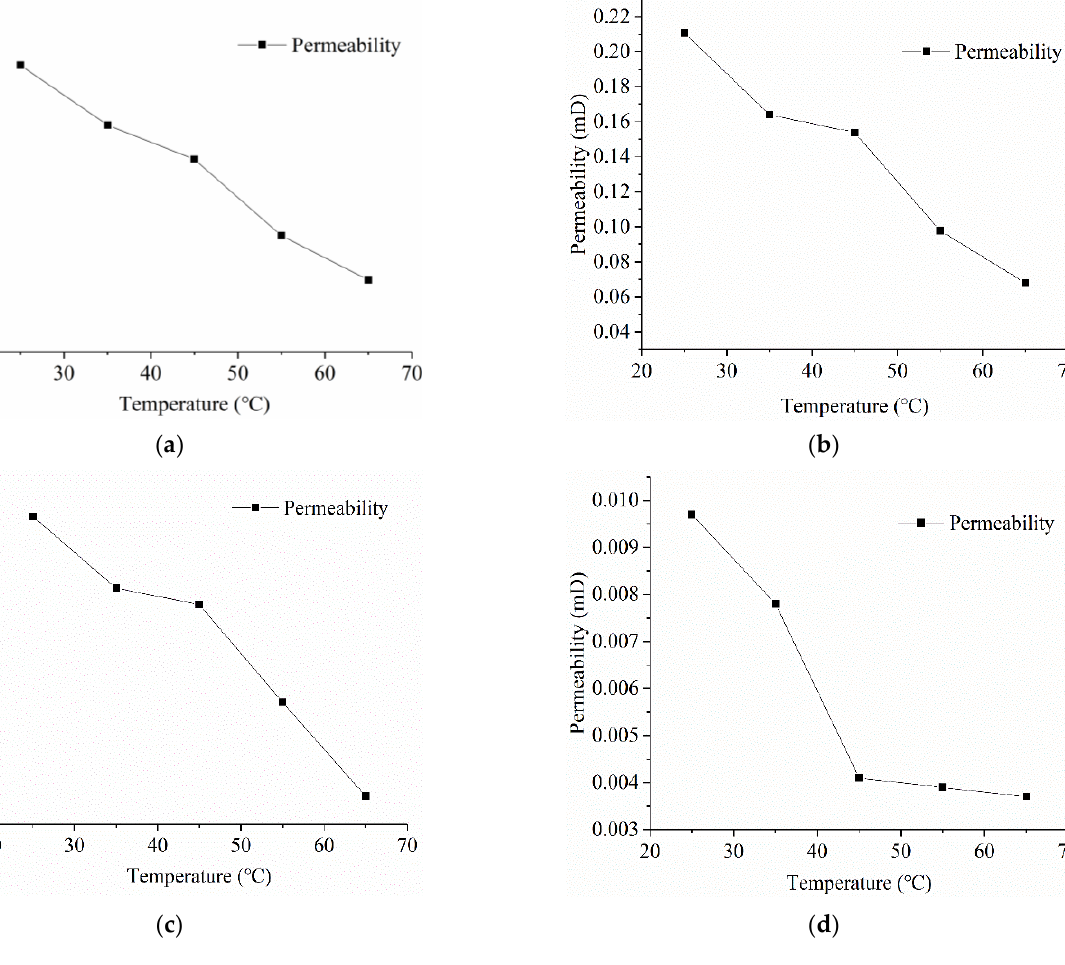
Figure 12. Permeability variation of the four subcategories of sandstone with different tempera-